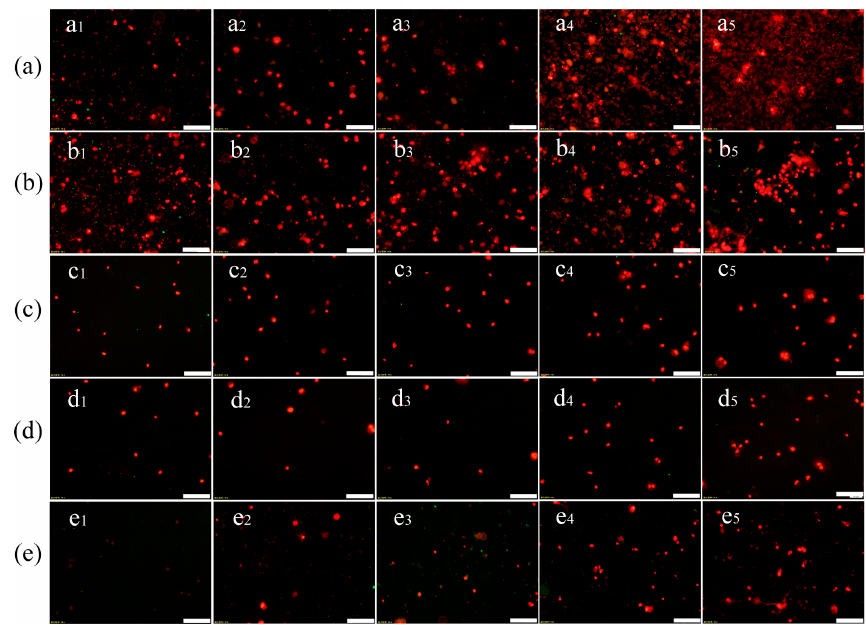
Figure 6. Fluorescence images of AGS cell apoptosis and fluorescence intensity. ( a ) Fluorescence images of exposing 500 nm PS-MPs (50, 100, 200, 400, 600 mg/L); ( b ) Fluorescence images of exposing 500 nm PS-TC MPs (50, 100, 200, 400, 600 mg/L); ( c ) Fluorescence images of exposing 60 nm PS-TC NPs (50, 100, 200, 400, 600 mg/L); ( d ) Fluorescence images of exposing 60 nm PS-NPs (50, 100, 200, 400, 600 mg/L); ( e ) Fluorescence images of exposing TC (0.5, 1, 5, 10, 20 mg/L); (scale: 250 μ m).